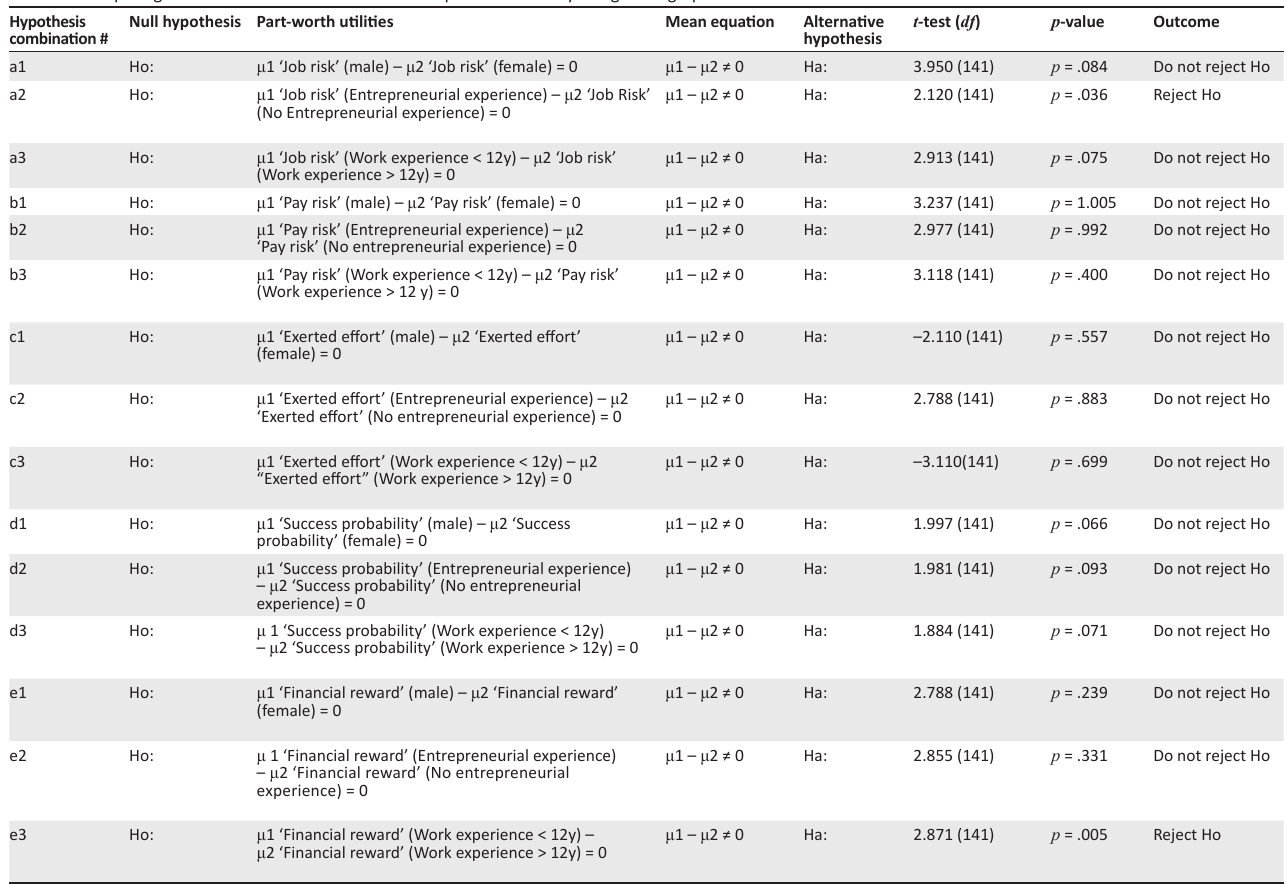
TABLE 3: Comparing statistical means for each attribute’s part-worth utility using demographic variables. Hypothesis Null hypothesis Part-worth utilities Mean equation combination #